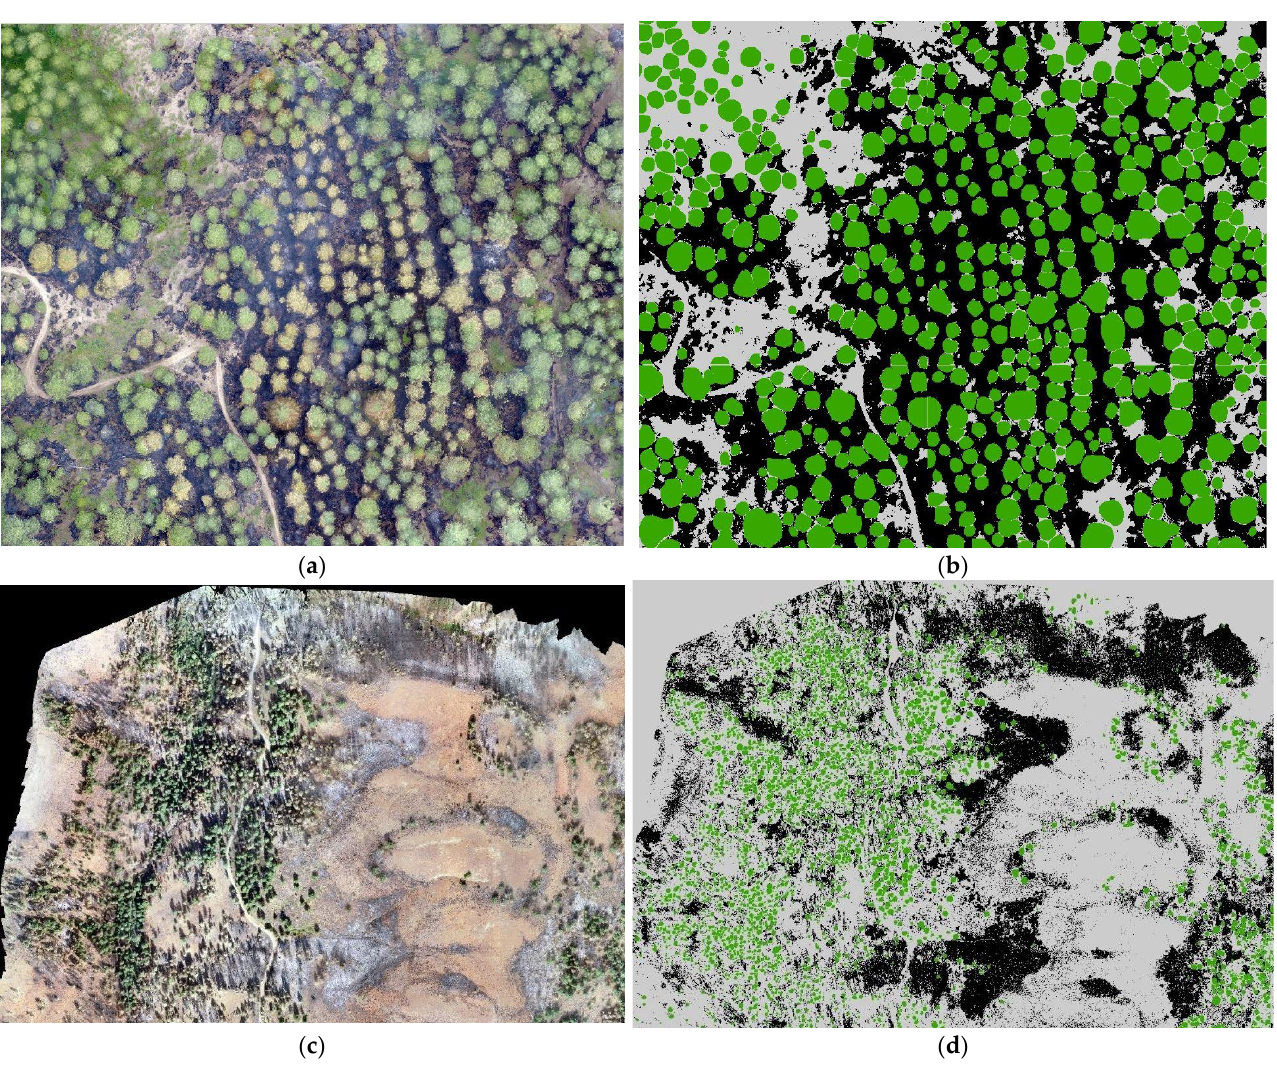
Figure 2. ( a ) Orthomosaic imagery from the Hoodoo fire ( b ) Combined raster results with surface represented by gray, burn represented by black, and canopy represented by green. ( c ) Orthomosaic imagery from the Mesa fire ( d ) Combined raster from the Mesa fire.